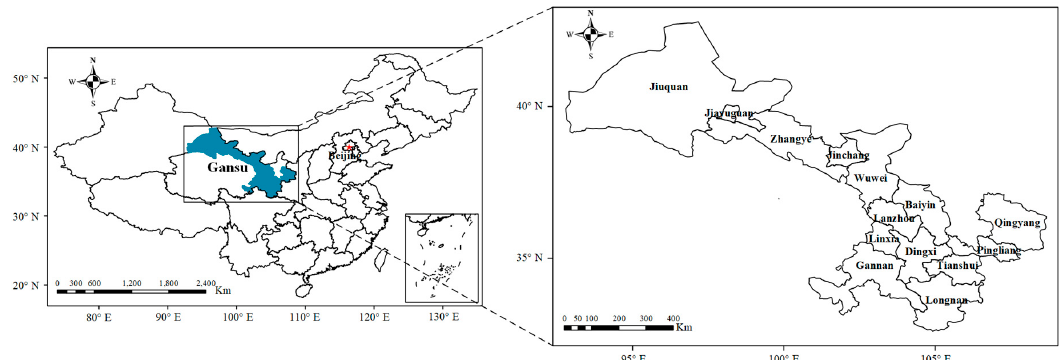
Figure 1. Geographical location of Gansu Province.